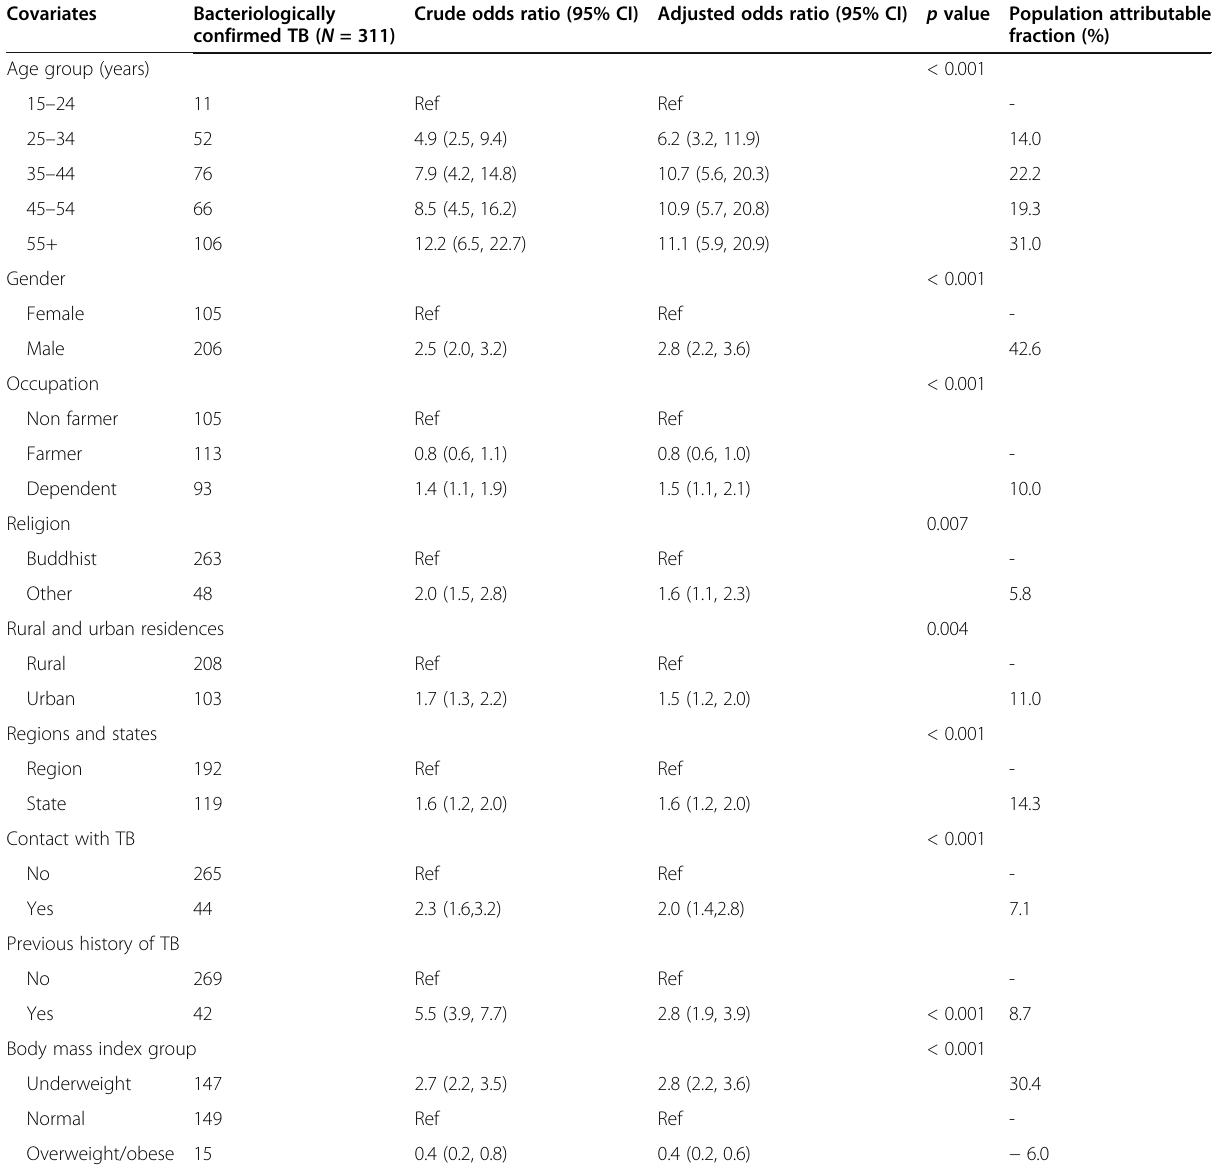
Table 5 Social pathology predictor variables associated with bacteriologically confirmed TB and their population attributable fraction